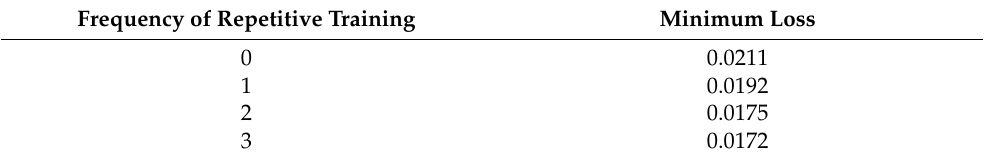
Table 2. Semi-supervised learning training